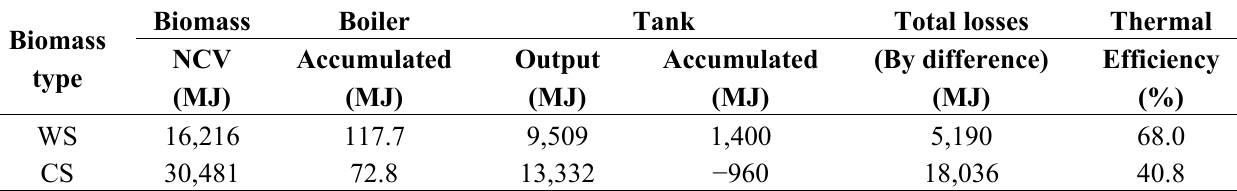
Table 5. Energy balance for WS and CS 2012 combustion trials.